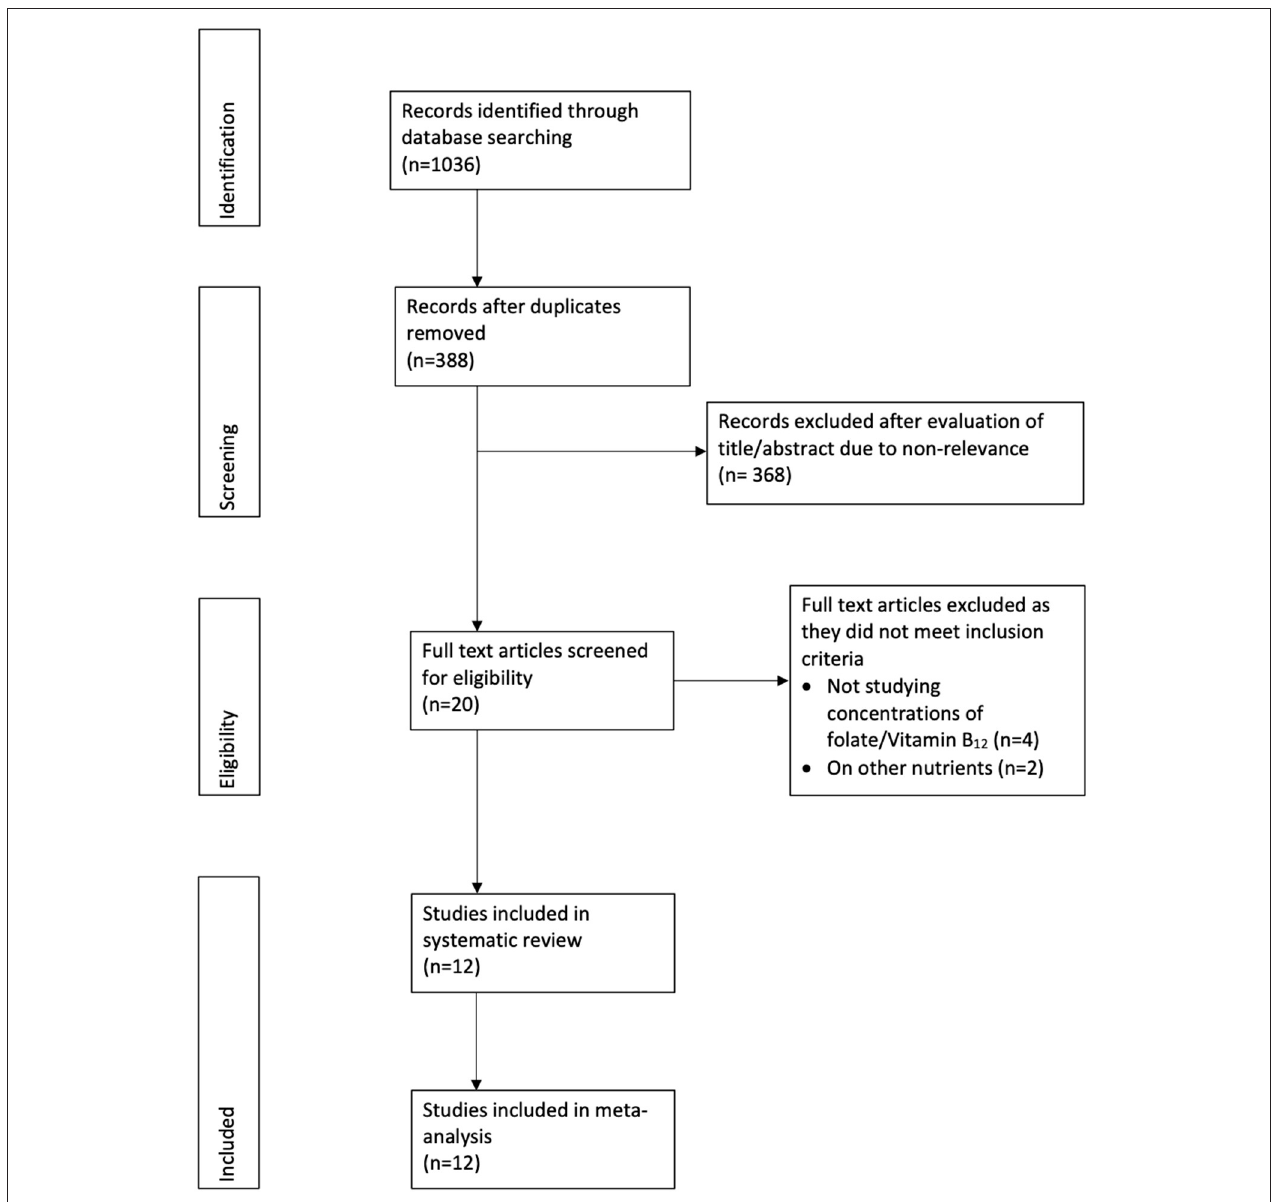
FIGURE 1 | Study flow chart.